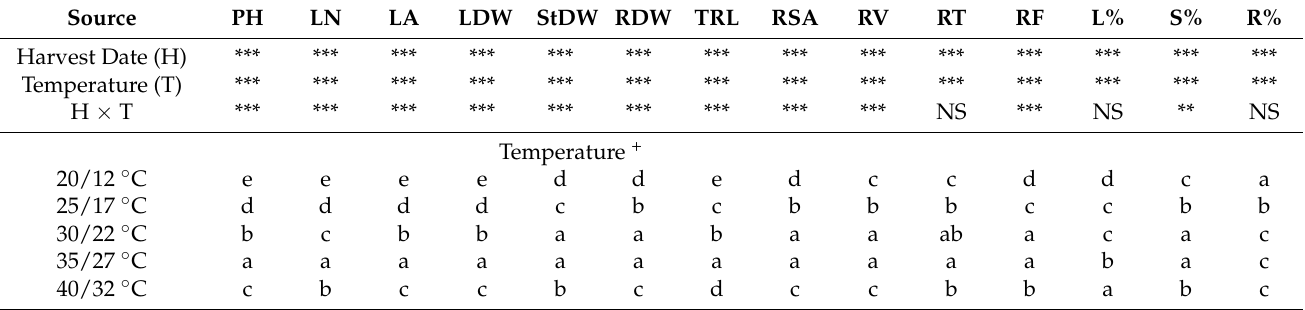
Table 2. Summary of analysis of variance across the harvest date (H), temperature treatment (T), and their interaction (H × T) on different root and shoot growth, physiological, and developmental traits measured weekly after emergence. Values are the mean of six replications for each harvest date at each temperature treatment. Plant height (PH), leaf number (LN), leaf area (LA), leaf dry weight (LDW), stem dry weight (StDW), root dry weight (RDW), the root to shoot ratio (RS), total dry weight (TDW), total root length (TRL), root surface area (RSA), root volume (RV), root tips (RT), root forks (RF); and leaf (L%), stem (S%), and root (R%) dry weight as a fraction of total dry